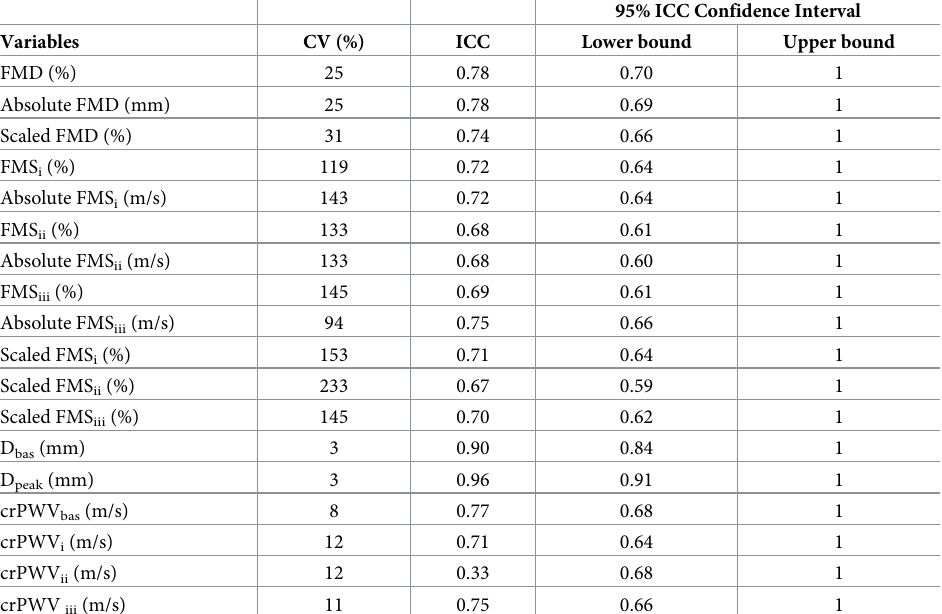
Table 3. Inter-day repeatability statistics.